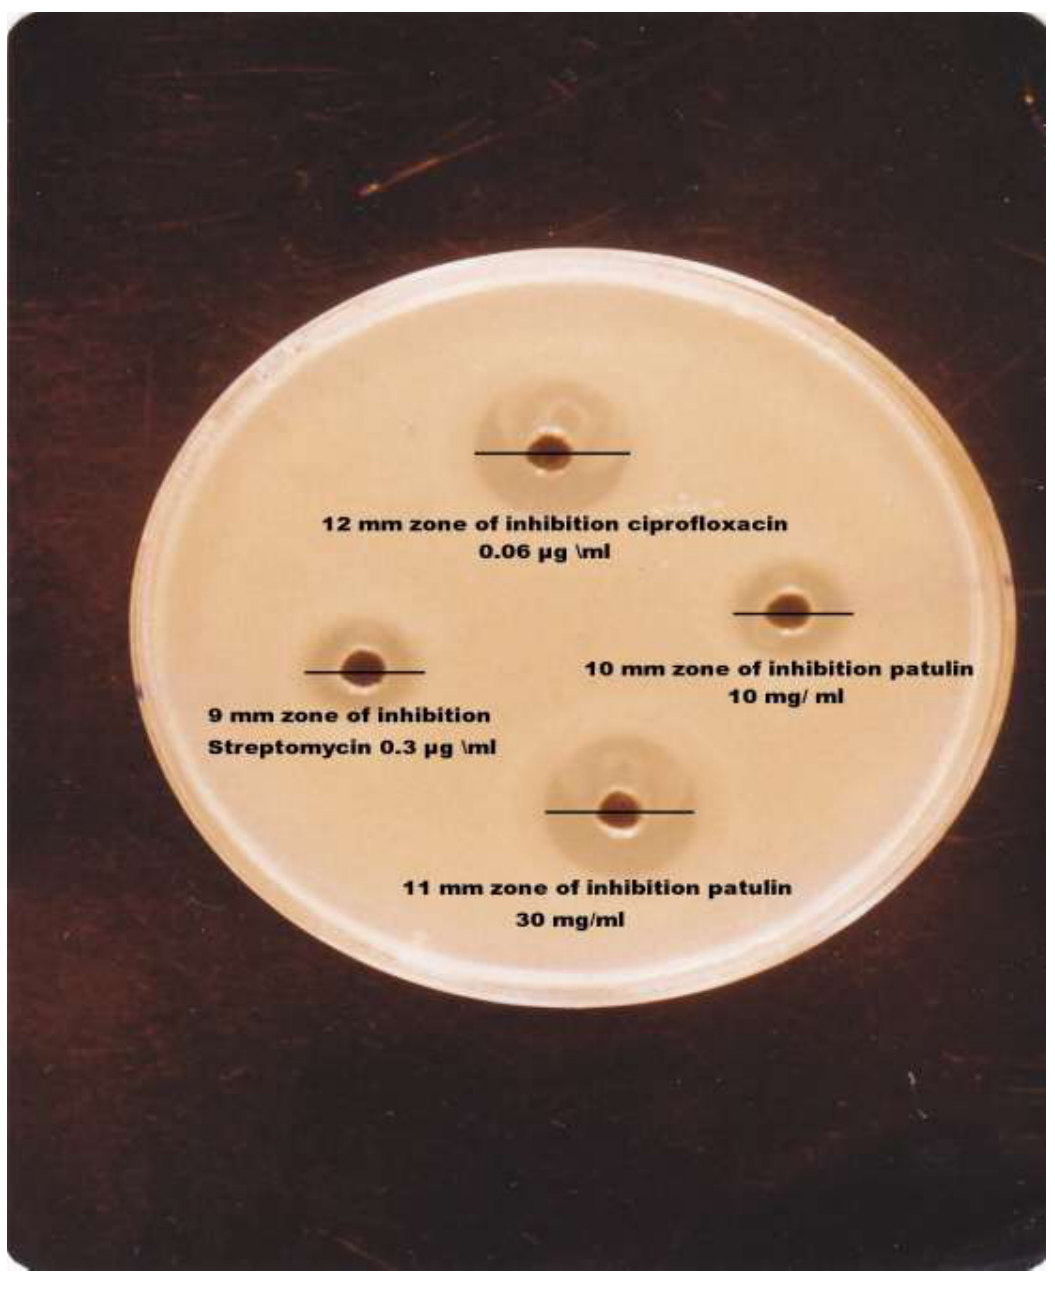
Figure (2): Demonstrate the zone of inhibition for Patulin extracted, and Streptomycin, Ciprofloxacin from standared against Staphyllococcus aureus inoculated in Muller Hinton agar